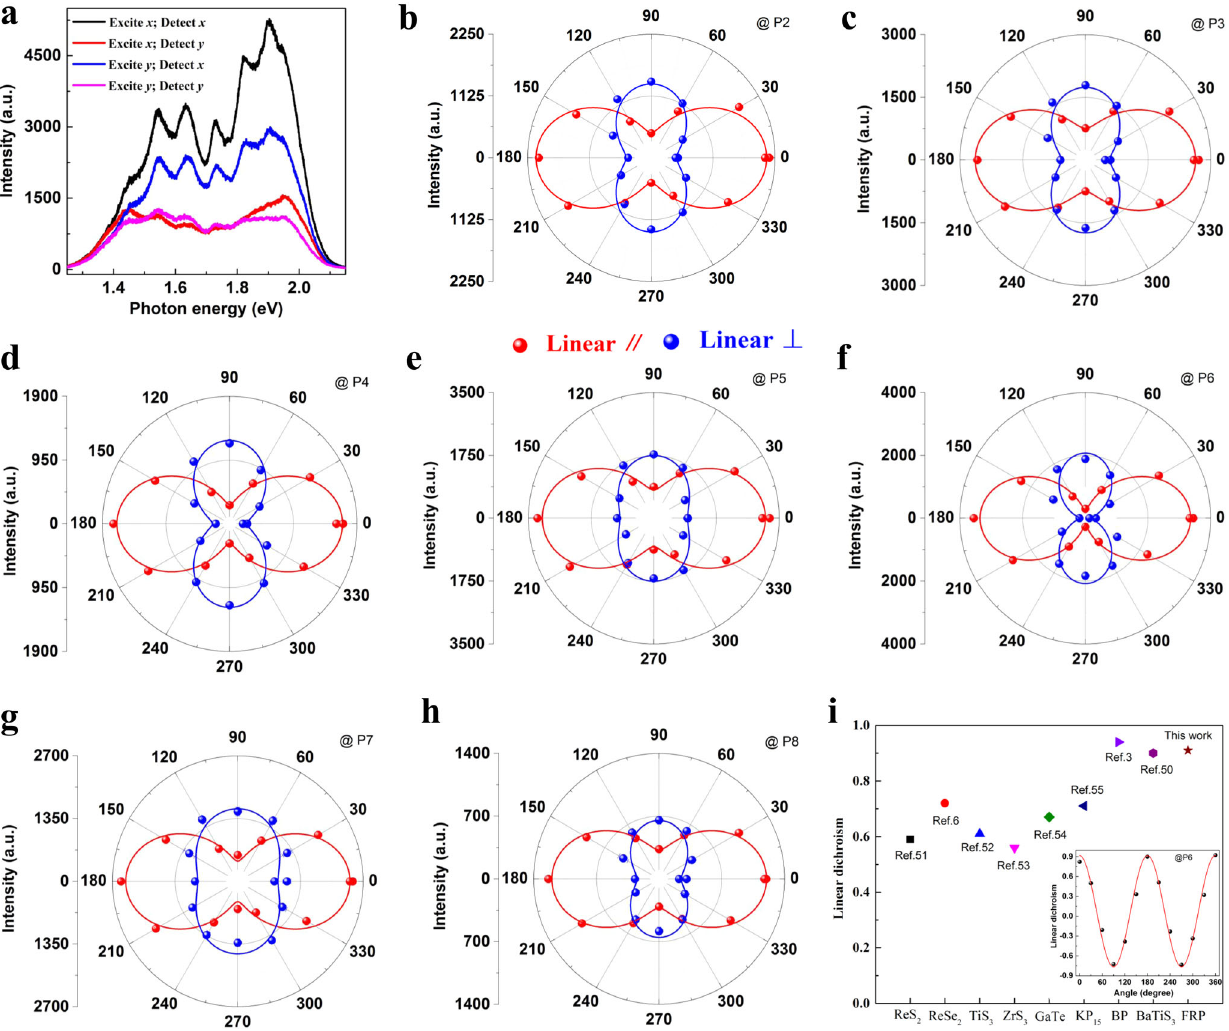
Fig. 3 Highly anisotropic PL emission in 1D vdW FRP. a PL spectra of a 1D vdW FRP fl ake under four different polarization con fi gurations with the 532 nm excitation laser. The x ( y ) axis is parallel (perpendicular) to the b direction of 1D vdW FRP crystal. b – h Polar plots of emission intensity of P2 – P8 as a function of polarization angle θ for copolarized (the polarizations of incident and emission light are parallel to each) and cross-polarized (the polarizations of incident and emission light are perpendicular to each) con fi gurations. The red (blue) solid lines are fi tted curves using a cos 2 θ (sin 2 θ ) function plus an offset. i The comparison of linear dichroism of FRP with the well-known quasi-1D van der Waals materials. The inset: the linear dichroism of P6 versus the polarization angle θ